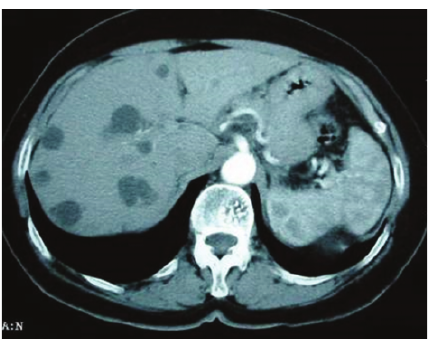
Figure 1: Abdominal and pelvic CT scan in a patient with hepa- torenal polycystic disease. Large hepatic cysts causing stenosis and displacement of the inferior vena cava and compression of the suprahepatic veins in relation to a Budd-Chiari syndrome.